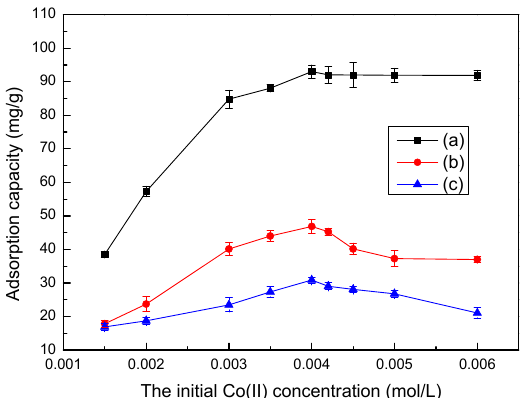
Figure 5. Effect of the initial cobalt ion (Co(II)) concentration on the adsorption capacity of LMT ( a ), MT ( b ), and LC ( c ). Adsorbent: 0.1000 g; pH: 5.6; temperature: 75 ◦ C; time: 60 min.